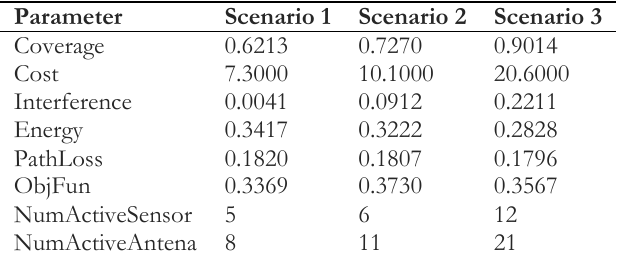
Table 8. Comparison of the results of the GA-SA algorithm for different scenarios.